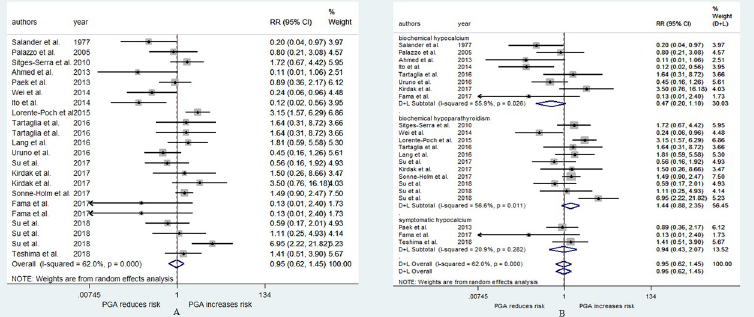
Fig 4. RR for permanent hypoparathyroidism in patients who underwent PGA vs patients who not underwent PGA. (A) overall relative risks. (B) the relative risk in subgroup of different evaluation indexes.